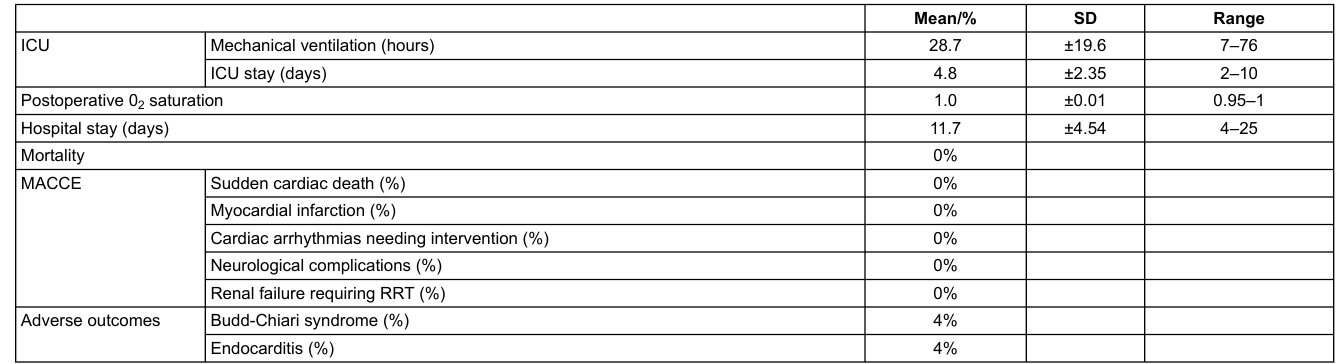
Table 3: Postoperative